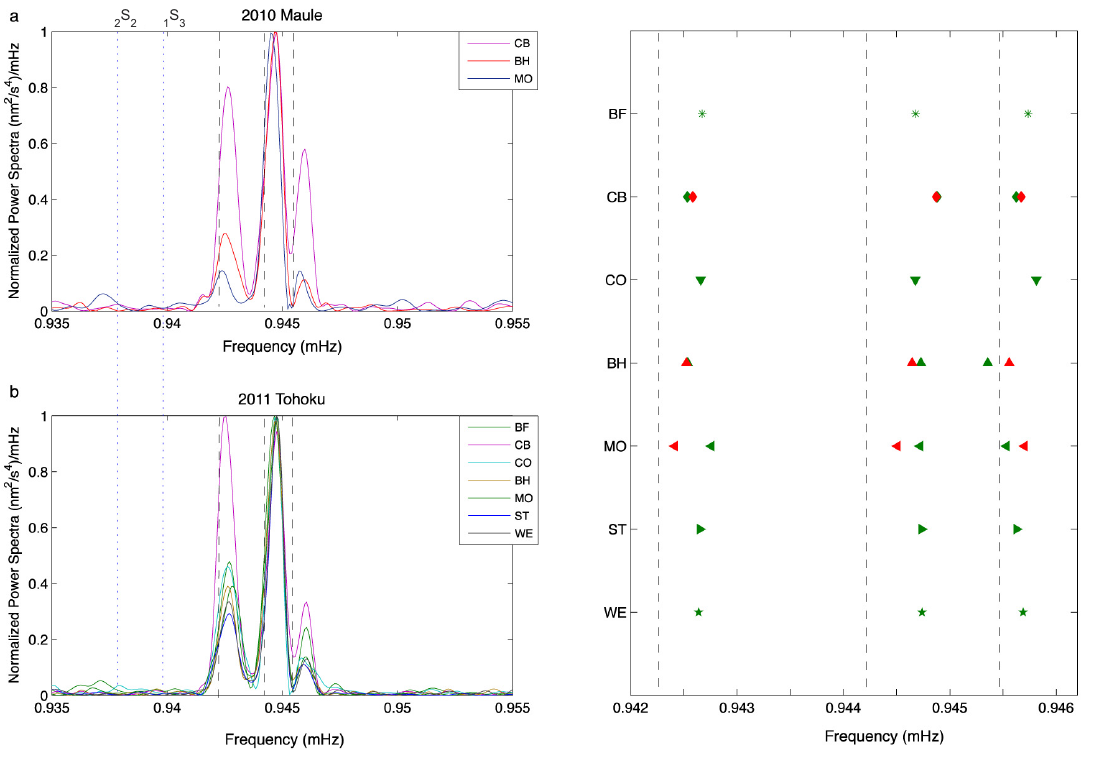
S based on the SG sequences after the 2010 and 2011 events. (a) The results of 3 residual gravity time se- Figure 6. The power spectra of 3 1 ries after the 2010 Maule event; (b) the results of 7 residual gravity time series after the 2011 Tohoku; (c) the estimated frequencies from dif- ferent series. The PREM predictions (from Roult et al. [2010]) are denoted by vertical dashed lines.